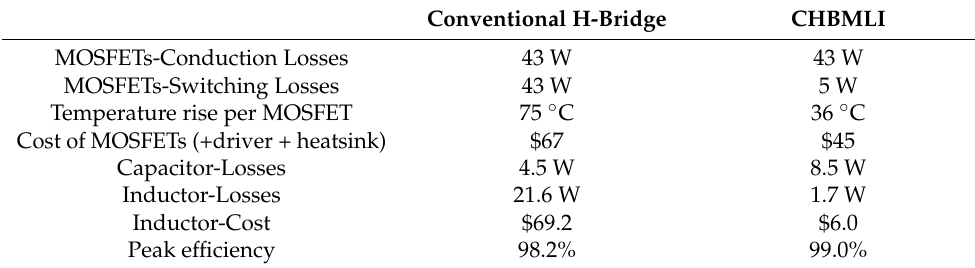
Table 11. Summary of comparison points between both